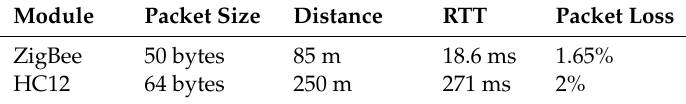
Figure 13. Network latency on different packet sizes. Table 4. Network performance comparisons between HC12 and ZigBee.